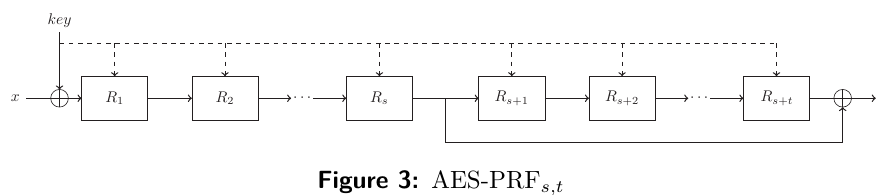
Figure 3: AES-PRF s,t